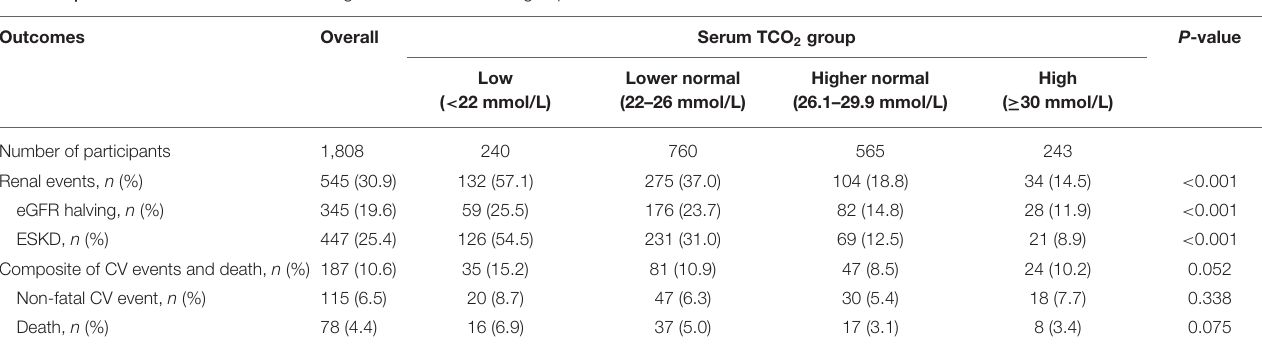
TABLE 2 | Outcome and event rates according to serum bicarbonate